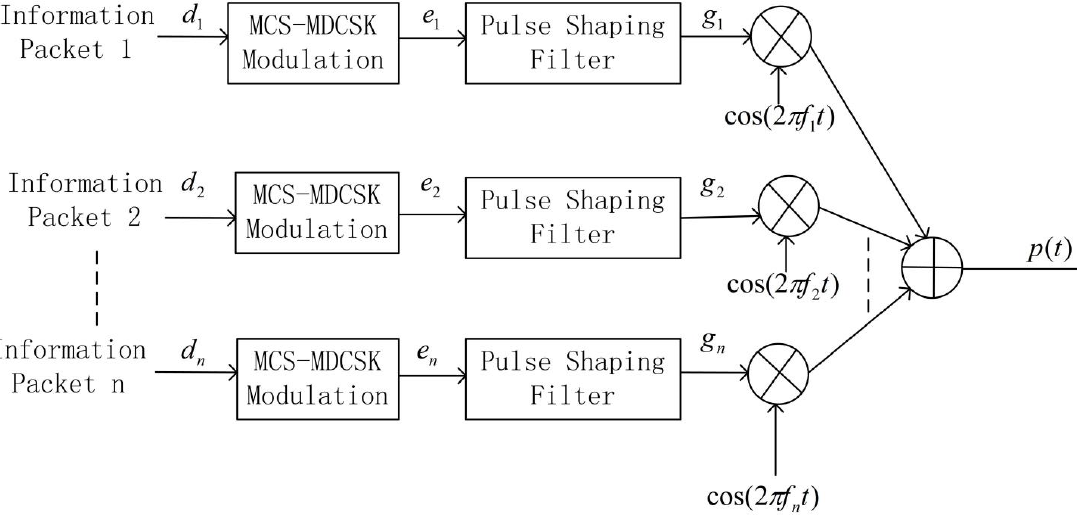
Figure 3. Block diagram of the MCS-MDCSK Modulation. ji e ,